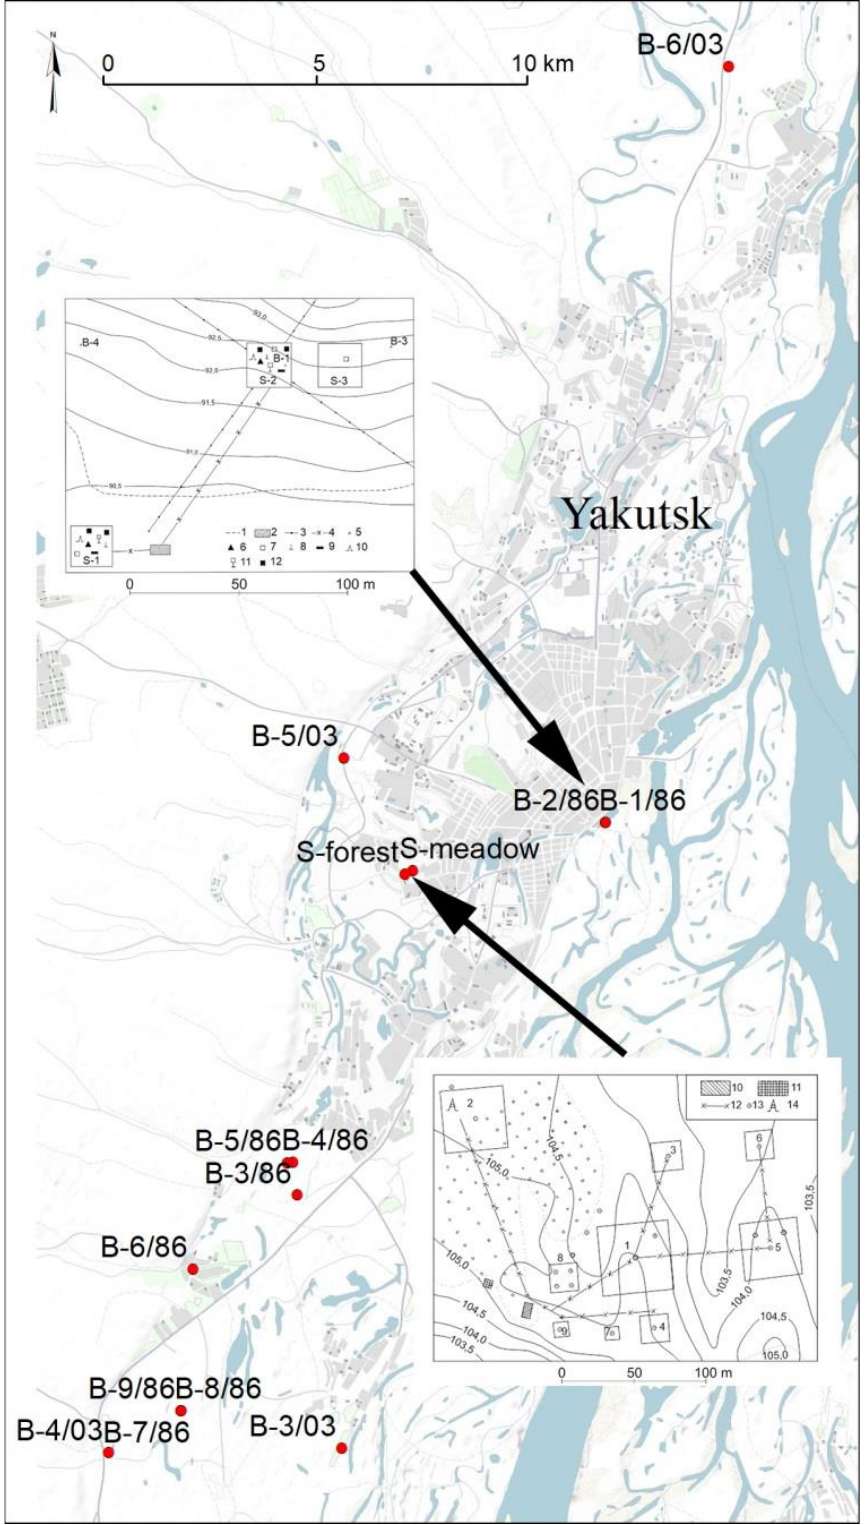
Figure 1. Scheme of experimental sites and thermometric boreholes in the Tuymaada Valley.